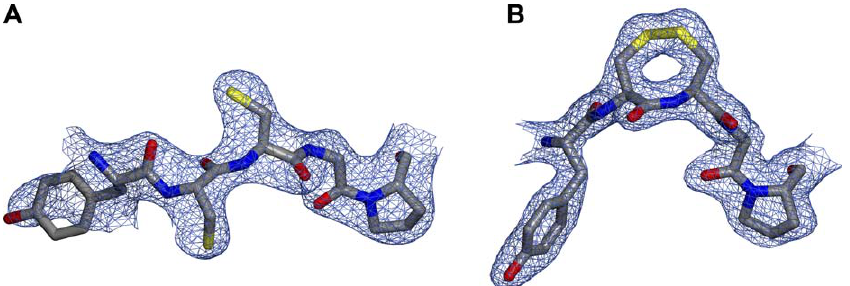
Figure 5. r A Weighted Electron Density Maps (2Fo-Fc) Contoured at 1 r in the Vicinity of Cys-370 and Cys-371 (A) In the GDP-bound structure [16], Cys-370 and Cys-371 are reduced. (B) In the inhibitor-bound structure, the cysteine residues form a vicinal disulfide bond, causing the intervening peptide bind to take on a cis configuration. (Carbon is indicated by grey, nitrogen by blue, oxygen by red, and sulfur by yellow.)